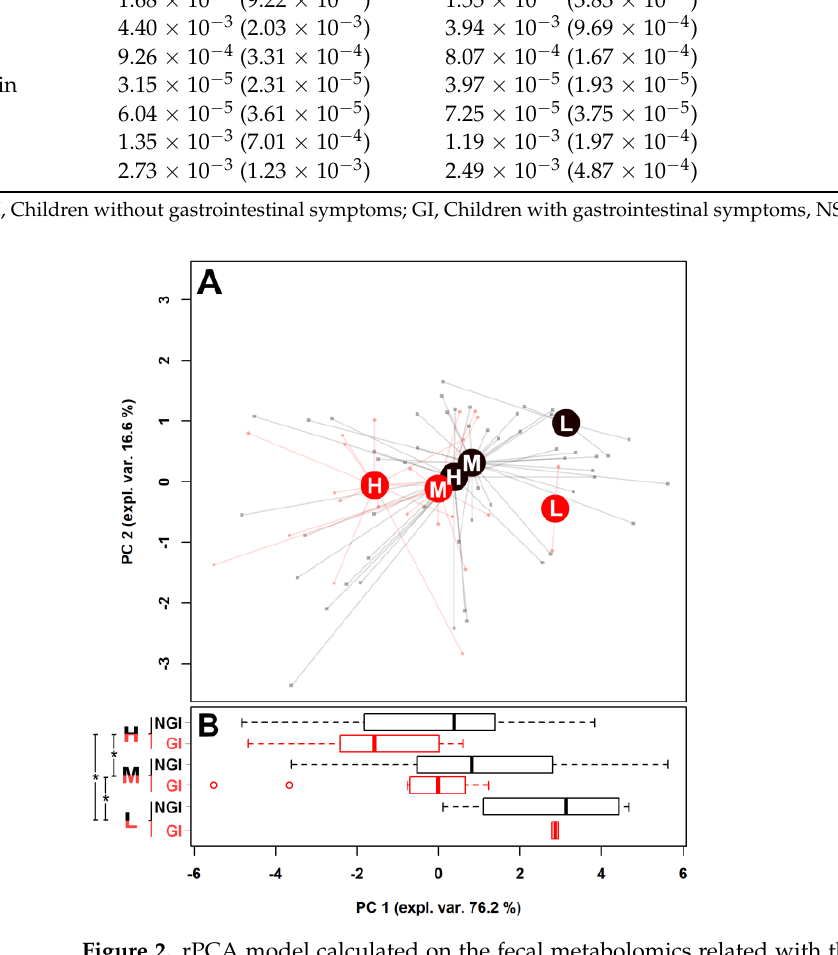
Figure 2. rPCA model calculated on the fecal metabolomics related with the molecules reported in Table 1b and adding the values relative to moderate-ADOS group (Table 2). ( A ) rPCA model of Figure 1 where moderate-ADOS children (M) were added within low-ADOS (L) and high-ADOS (H) groups. The score plot reports the samples joined with lines to their median values, represented with big filled circles. Children without (NGI) and with gastrointestinal symptoms (GI) are evidenced with black or red colors, respectively. ( B ) Boxplot summarizing the position of the groups along PC 1. Asterisks denote significant ( p < 0.05) pairwise differences. Children without (NGI) and with gastrointestinal symptoms (GI) are evidenced with black or red colors, respectively. Both moderate-ADOS + NGI and moderate-ADOS + GI children appeared as charac- terized by PC 1 scores intermediate to the corresponding low-ADOS and high-ADOS. In